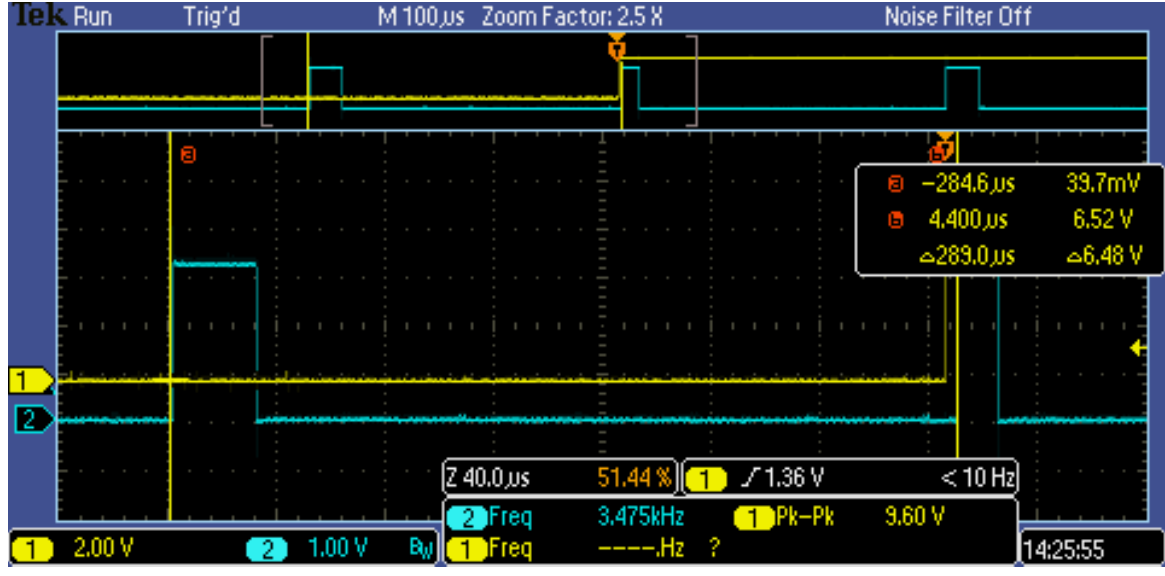
Figure 24. Oscilloscope capture of 3.2 kHz rising edge timing after PPS signal.